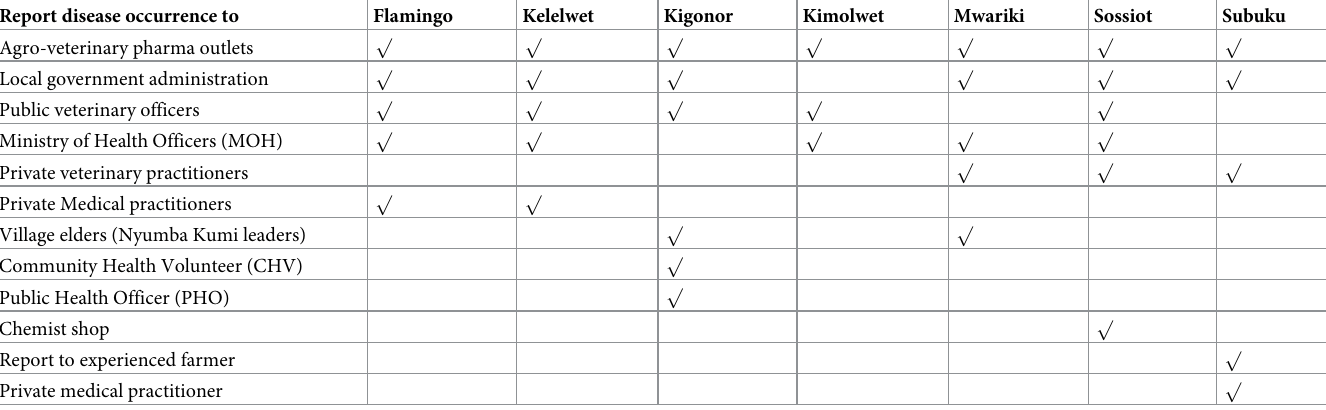
Table 4. People to whom the focus group participant would report disease occurrence in their farms to in Nakuru, Kenya, 2020. Report disease occurrence